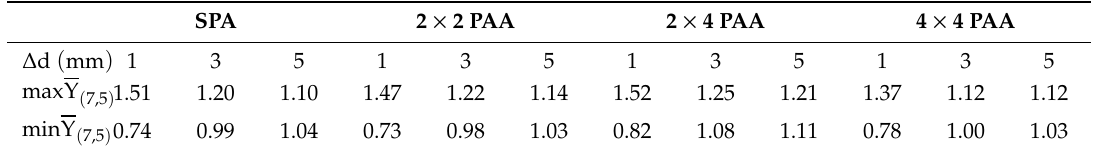
Table 4. Average Υ ( 7,5 ) over ∆